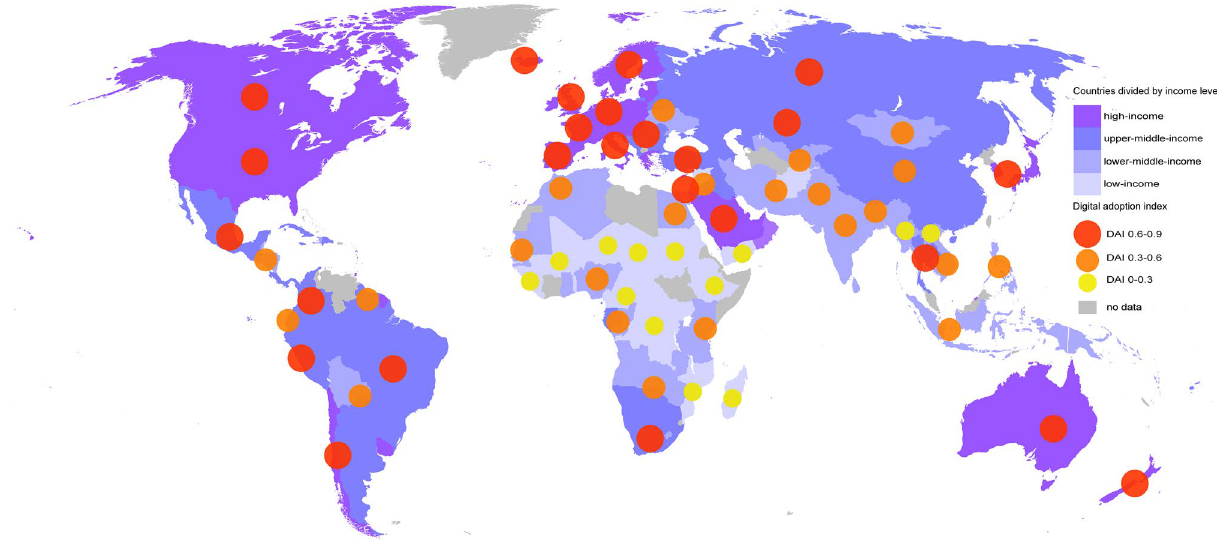
Figure 5. Global level of digital adoption by income. Digital adoption by country is represented by the digital adoption index (DAI), chosen as the one representative score covering numerous countries. The DAI is based on three sub-indices implying governments, businesses, and people. Regions include economies at all income levels 37 . Adoption of digital technologies varies across countries, with higher- and upper-middle-income countries scoring a higher DAI. As Singapore reached the highest DAI index of 0.87, we divided the DAI into three increments up to 0.9. This map was adapted from https:// de. wikip edia. org/ wiki/ Datei: Blank Map- World- v2. svg# file 38